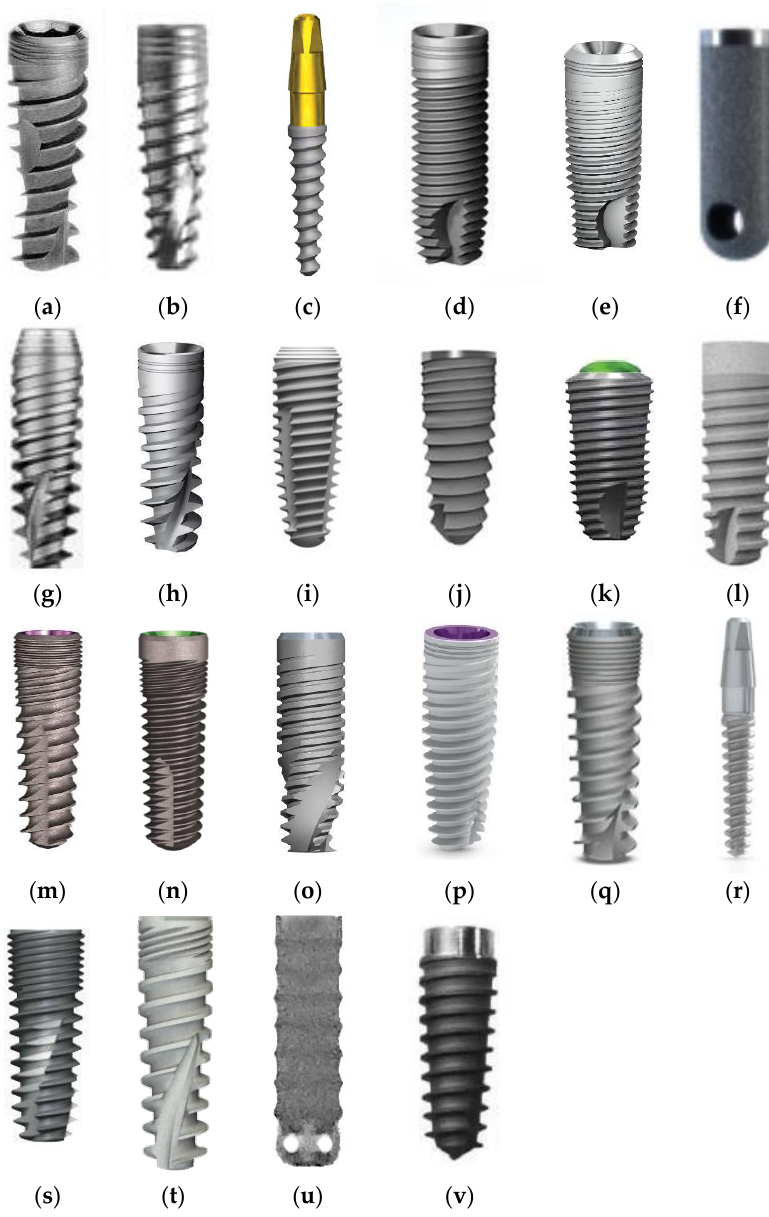
Figure 1. The appearance of the dental implants compared in this study, in alphabetical order: ( a ) AB Dental Devices I5; ( b ) ADIN Dental Implants Touareg; ( c ) Alpha Bio ARRP; ( d ) Alpha Bio ATI; ( e ) Alpha Bio DFI; ( f ) Alpha Bio OCI; ( g ) Alpha Bio SFB; ( h ) Alpha Bio SPI; ( i ) Argon Medical Pro- ductions K3pro Rapid; ( j ) Bego Semados RI; ( k ) Dentium Super Line; ( l ) Friadent Ankylos C/X; ( m ) Implant Direct InterActive; ( n ) Implant Direct Legacy 3; ( o ) MIS BioCom M4; ( p ) MIS C1; ( q ) MIS Seven; ( r ) MIS UNO One Piece; ( s ) Osstem Implant Company GS III; ( t ) SGS Dental P7N; ( u ) TBR Implanté; ( v ) Wolf Dental Conical Screw-Type.